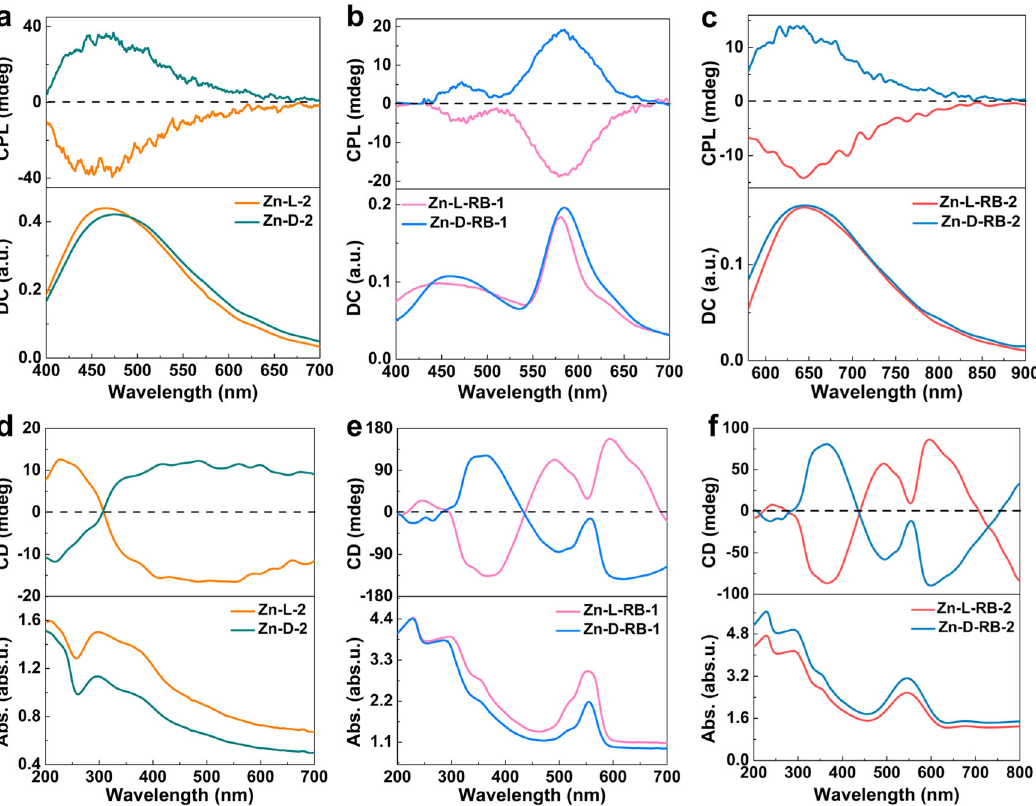
Fig. 5 | The CPL properties of the SGs. a – c The CPL spectra of Zn – L/D-2, Zn – L/D-RB-1 and Zn – L/D-RB-2 SGs excited by 365, 380, and 400nm, respectively. “ DC ” is analogous to “ PL intensity ” . d – f The CD and UV-Vis absorption spectra of these